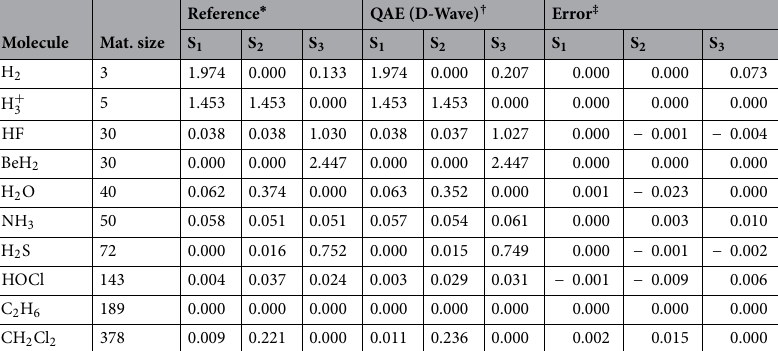
Table 3. Singlet TDDFT transition dipole moments (au). ∗ Reference calculation on CPU using unmodified PySCF. † PySCF was modified to use the QAE and D-Wave 2000Q. ‡ Difference between the two types of